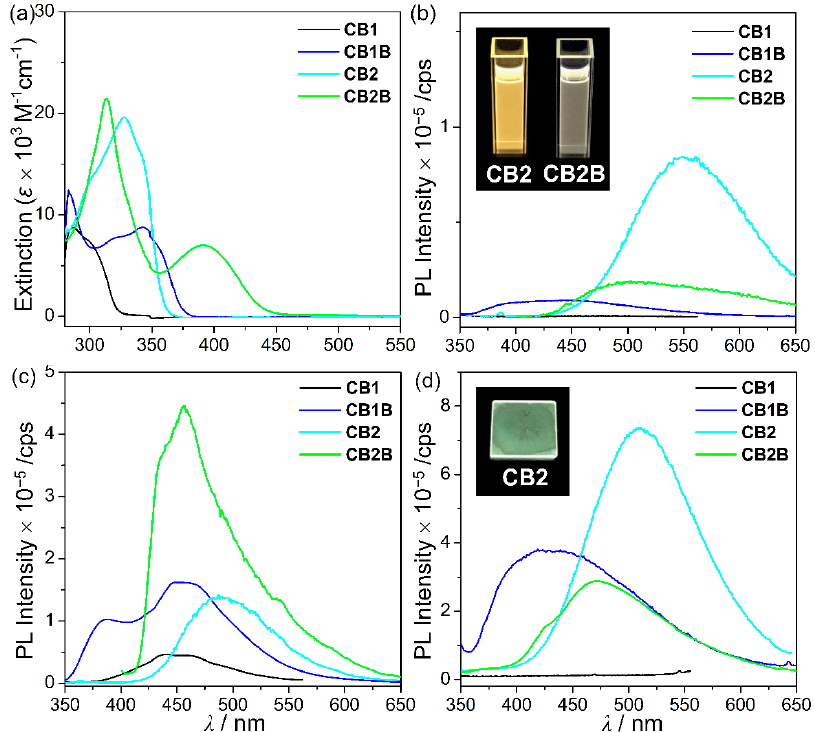
Figure 3. (a) UV-vis absorption spectra in toluene (5.0 × 10 − 5 M). Photoluminescence (PL) spectra in toluene (5.0 × 10 − 5 M) at ( b ) 298 and ( c ) 77 K. ( d ) PL spectra in film state (poly(methylmethacrylate) (PMMA) film doped with 5 wt % o -carbonyl compound). Inset figures show the color of the emission of each state under UV irradiation ( λ ex = 354 nm).